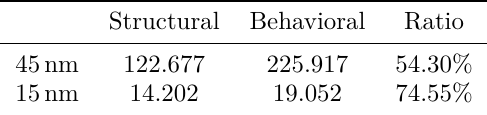
Table 4: Latency of the circuits for 6-bit S-box used in Example 4 using behavioral and structural modes of implementation in NanGate 15 nm and 45 nm